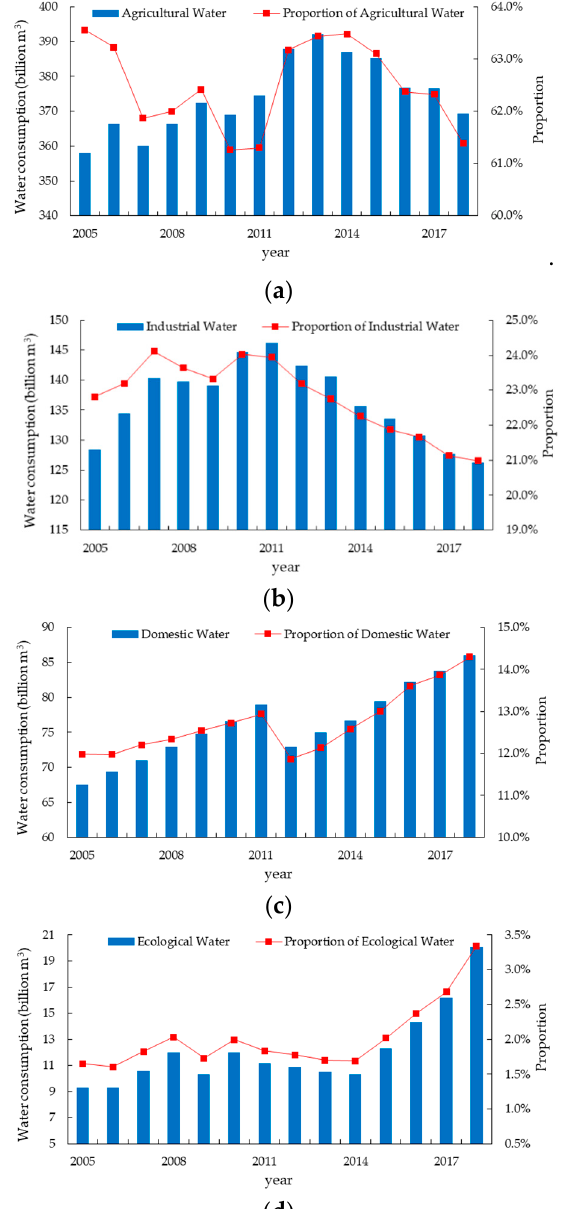
Figure 1. Annual water consumption by various water users and its share in total water consumption as follows: ( a ) agricultural water; ( b ) industrial water; ( c ) domestic water; ( d ) ecological water.